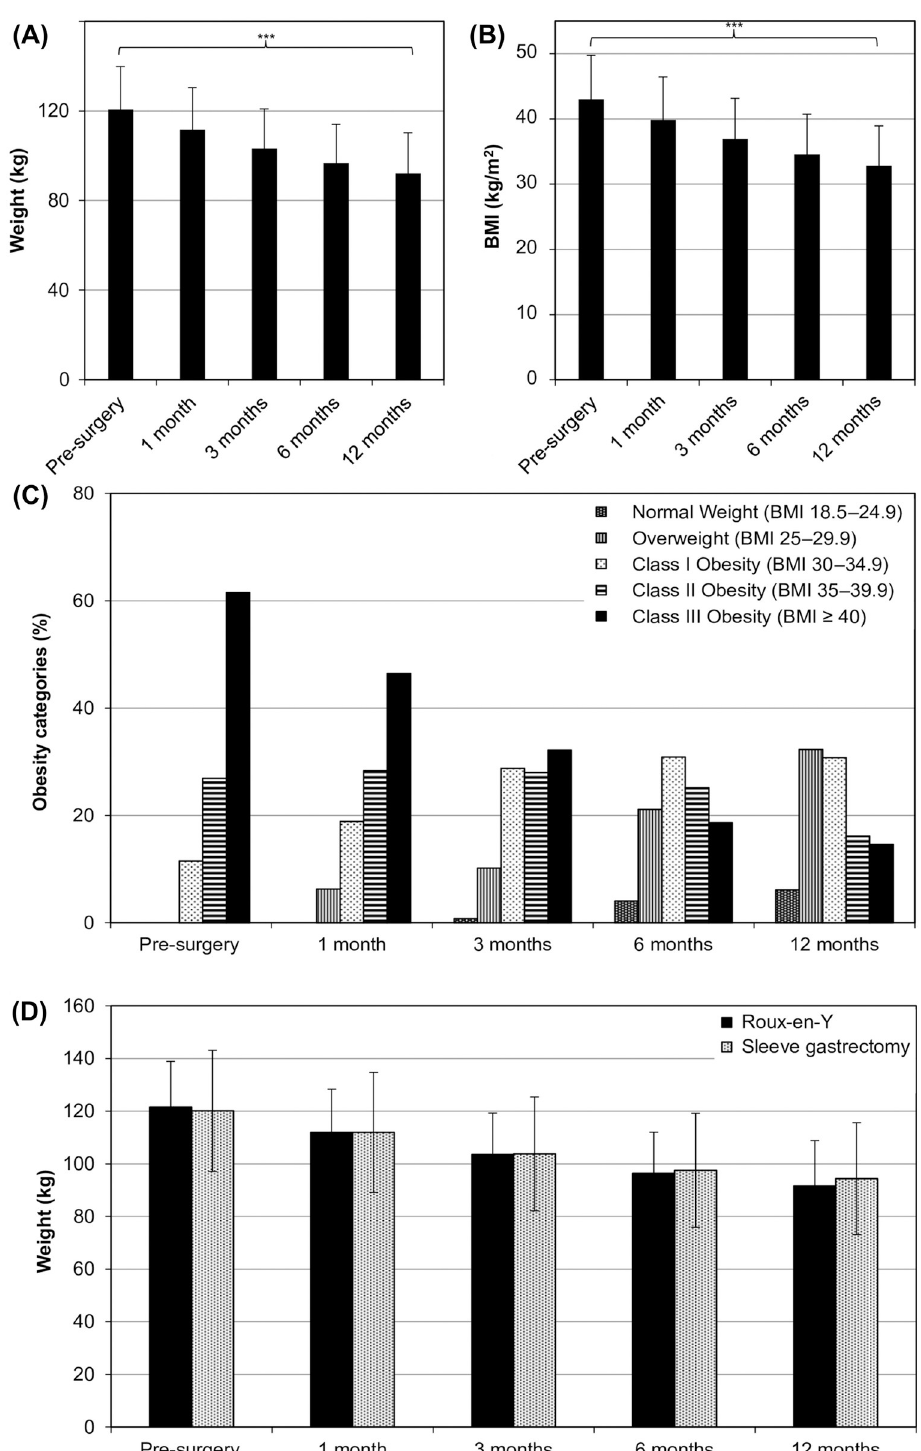
Fig 1. Changes to body weight and body mass index following bariatric surgery. (A) Body weight and (B) BMI were measured prior to bariatric surgery and at 1-, 3-, 6-, and 12-month follow-ups and (C) the patient distribution across obesity classes was tracked throughout this period. Similarly, (D) the weight loss of patients who underwent different surgical procedures was tracked. N = 130; 89 patients had RYGB, while 41 underwent sleeve gastrectomy. ��� p <